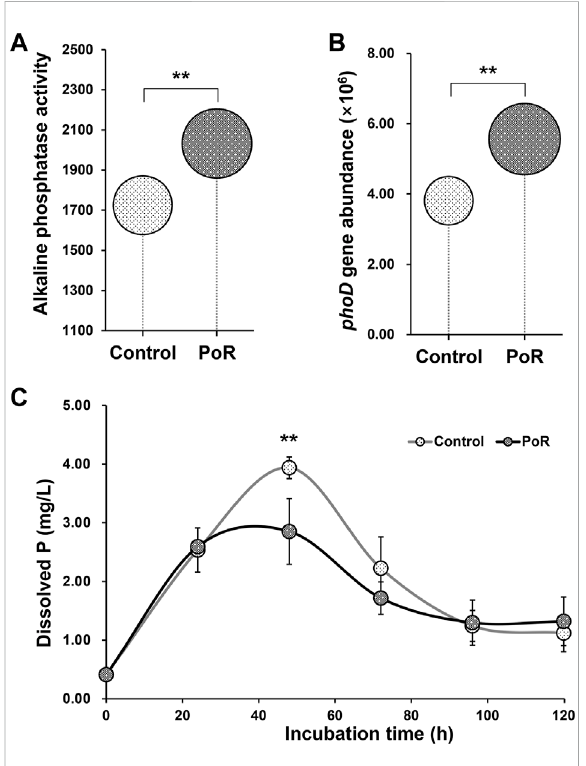
FIGURE 3 Alkaline phosphatase activity (nM p -NPP h − 1 g − 1 dry soil) (A) and the abundance of the phoD gene (number of copies g − 1 dry soil) (B) in soil having undergone PoR and control treatments; dynamics of inorganic P-solubilization by microbes under control and PoR treatments (C) . ** indicates a signi fi cant differencebetweenPoRandcontrol(Kruskal – Wallisranksumtest, p <